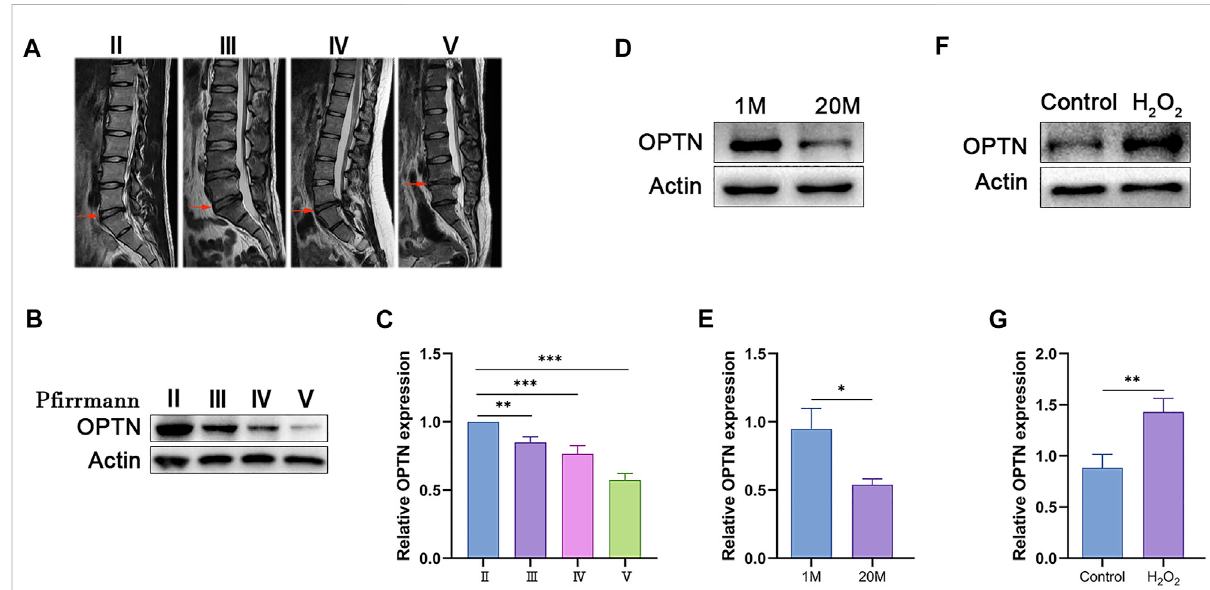
FIGURE 1 OPTN level decreased in degenerated NP tissue and increased in H 2 O 2 -teated rat NPCs. (A) different degrees of IVDD MRI images of patients. (B – C) Western blot and quanti fi cation of OPTN in human NP tissue. (D – G) Western blot and quanti fi cation of OPTN in rat NP tissues and H 2 O 2 - teated NPCs. Experiments involving human NP specimen were performed as means ± SD of 5 times in duplicates. Experiments involving rat NP specimen were performed as means ± SD of 3 times in duplicates. * p < 0.05, ** p < 0.01, *** p < 0.001, ns p >